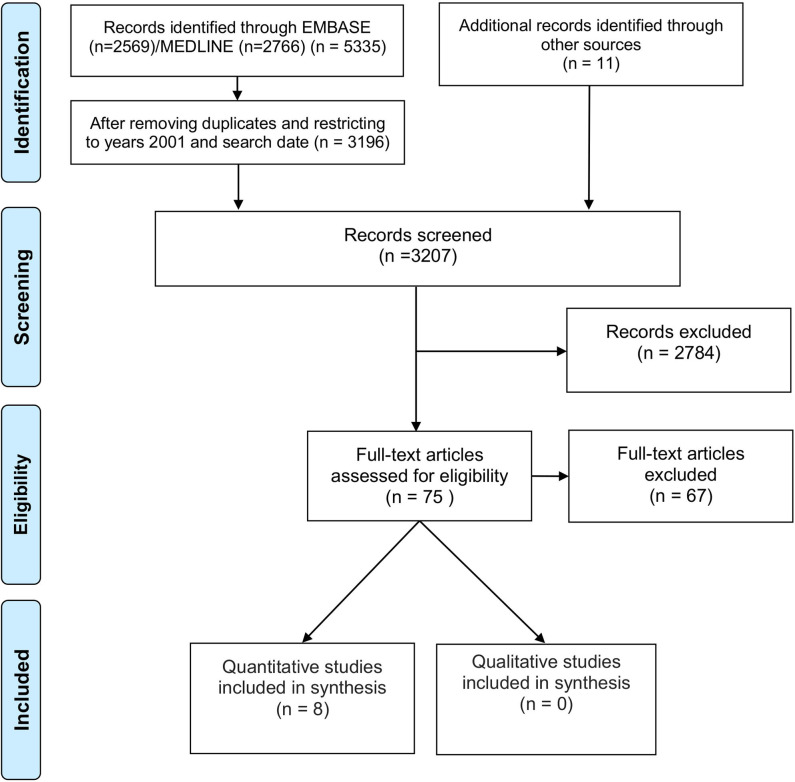
Study flow diagram.